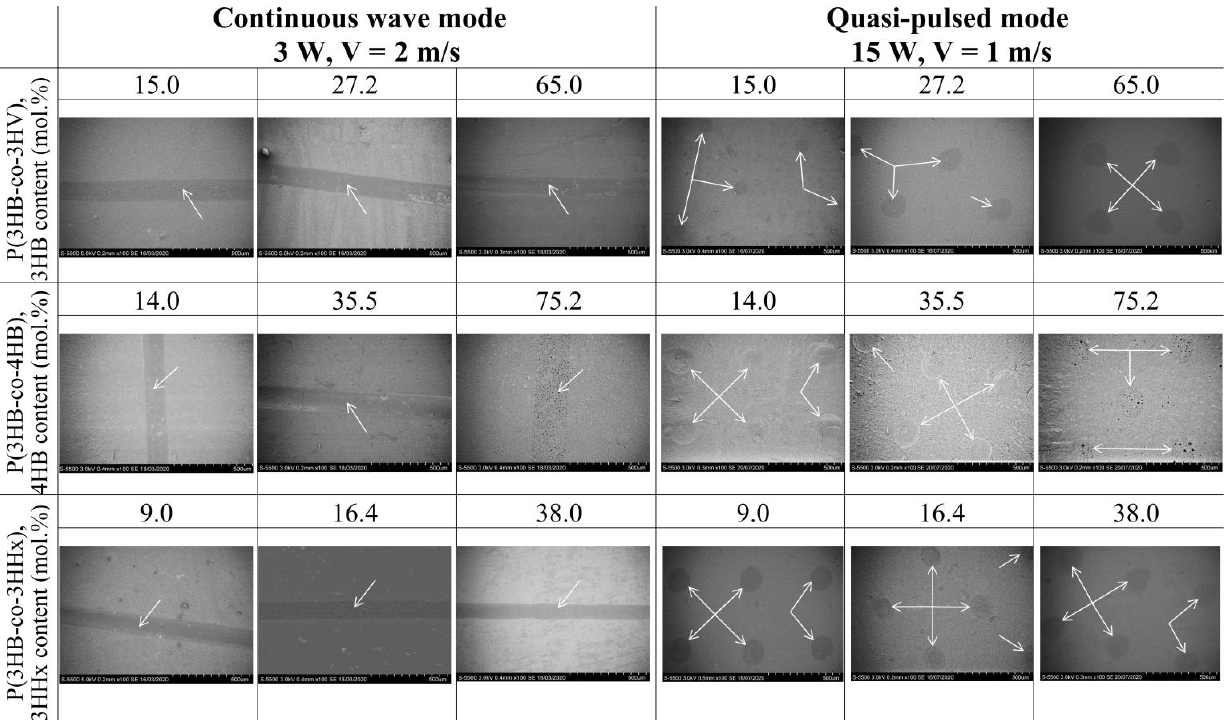
Figure 2. SEM images of surfaces of the laser-treated films prepared from PHAs with different compositions. Bar = 500 µm . Arrows indicate ablated zones.